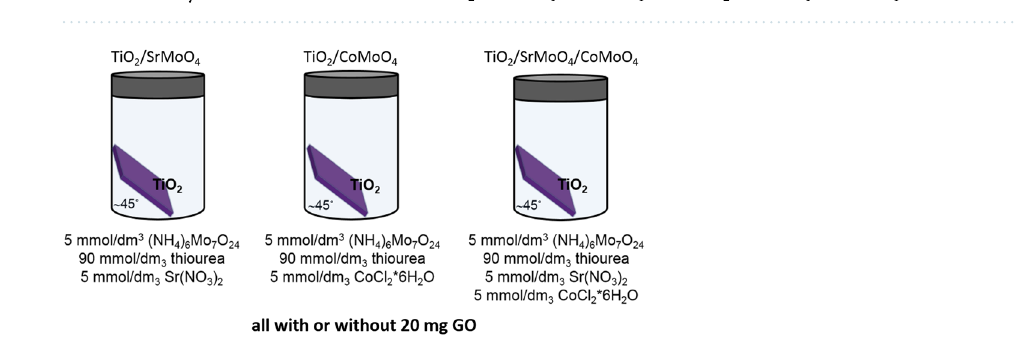
Figure 8. Part variations of overvoltage value at a constant current density of 10 mA cm −2 with the processing time for ( a ) without and ( b ) with the addition of carbon. ( c ) Chronopotentiometry measurement with the current density of 10 mA cm −2 for 8 h for TiO 2 /SrMoO 4 /CoMoO 4 and TiO 2 /SrMoO 4 /CoMoO 4 /GO.